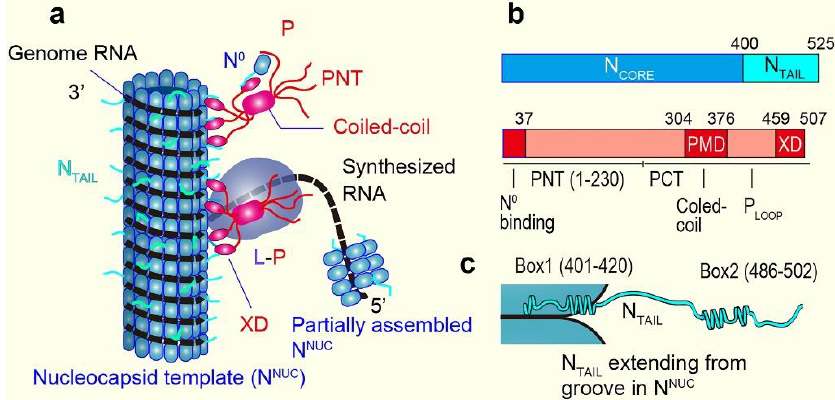
Figure 4. Measles virus IDPs, N and P. ( a ) Schematic showing complexes of N 0 – P, N NUC – P, and L – P RNA polymerase. The location of RNA is schematically represented for its visualization. Only a part of N TAIL s is shown. ( b ) Domain diagrams of N and P proteins. The light-color regions indicate IDRs. ( c ) Schematic showing N TAIL extending from the groove of nucleocapsid template.